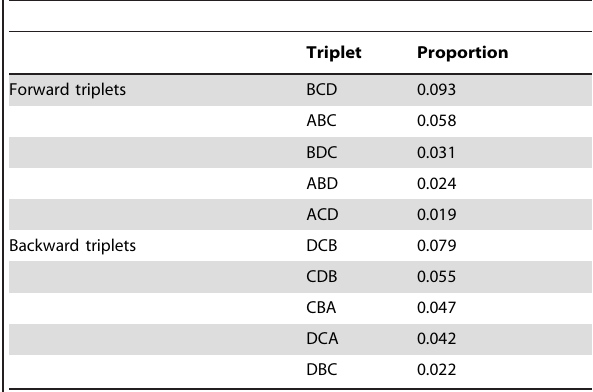
Table 1. The 50% most frequent forward and backward fixation triplets.